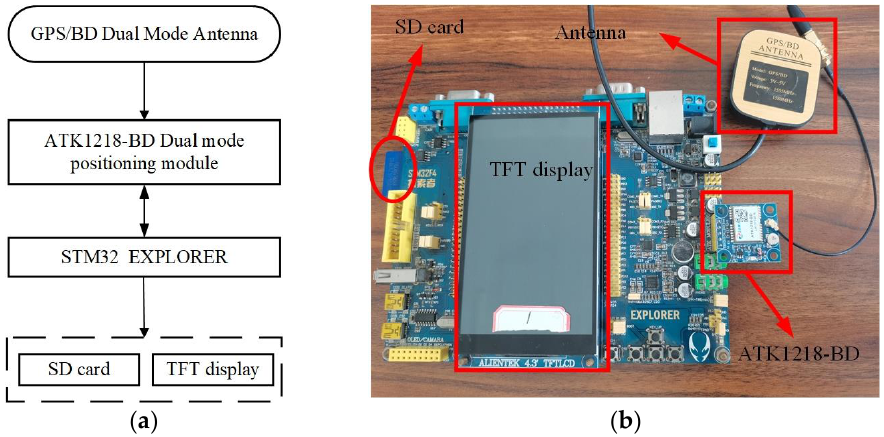
Figure 4. Low-cost positioning system. ( a ) Hardware design diagram; ( b ) physical system diagram.